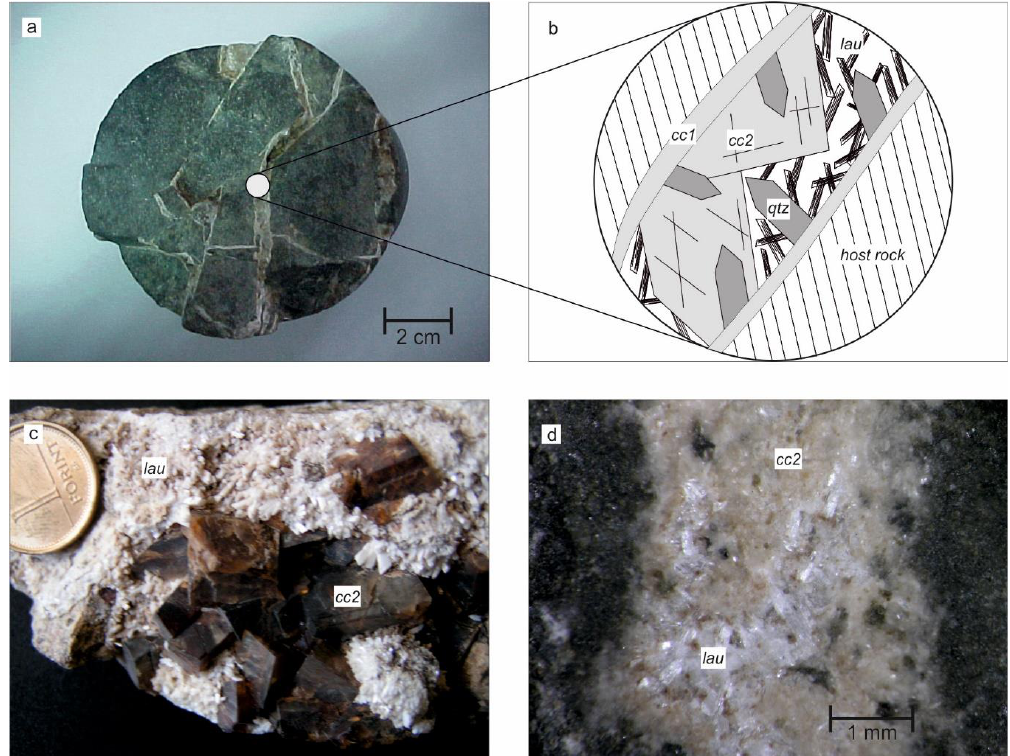
Figure 5. Typical vein-filling mineralogy of the amphibolite. ( a ) Representative fractured amphibolite bore core. ( b ) Sketch of the vein-filling mineral sequence. ( c ) Open vein with brown calcite2 and laumontite. The coin is 16 mm in diameter. ( d ) Vein filled by calcite2 and laumontite.